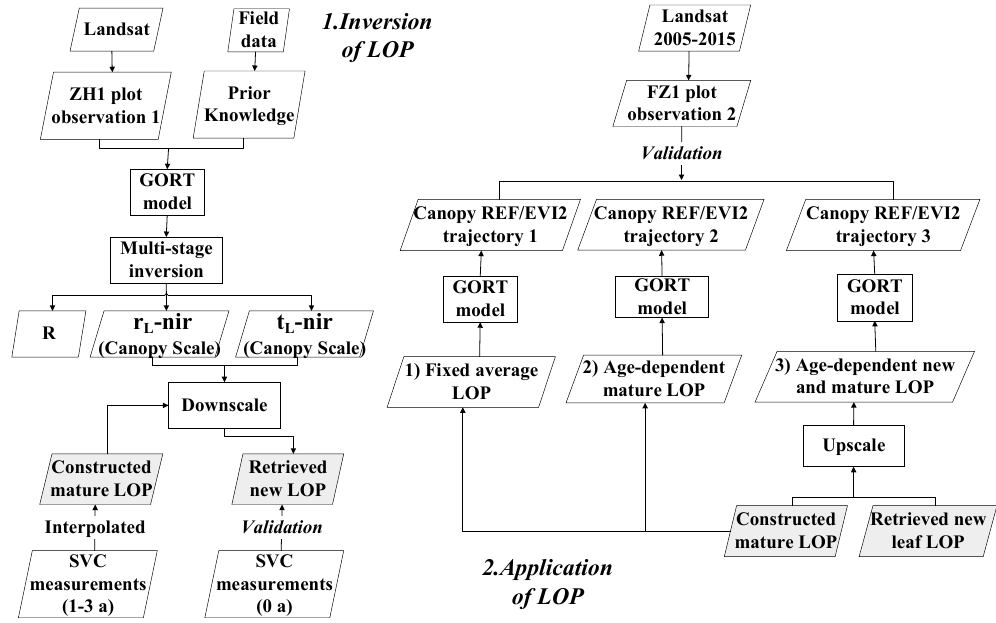
Figure 3. Flow chart of LOPs retrieval and application method.